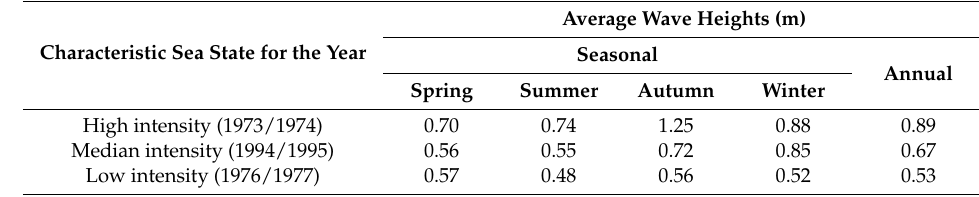
Table 3. Average seasonal and annual wave heights for the design years along the coast of Klaip˙eda. Average Wave Heights